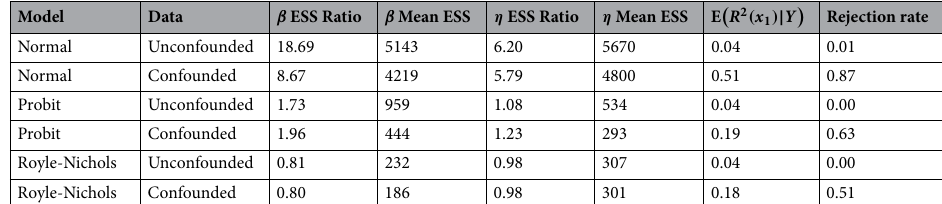
2 ( x 2 of 1 ) | Y is the posterior mean R